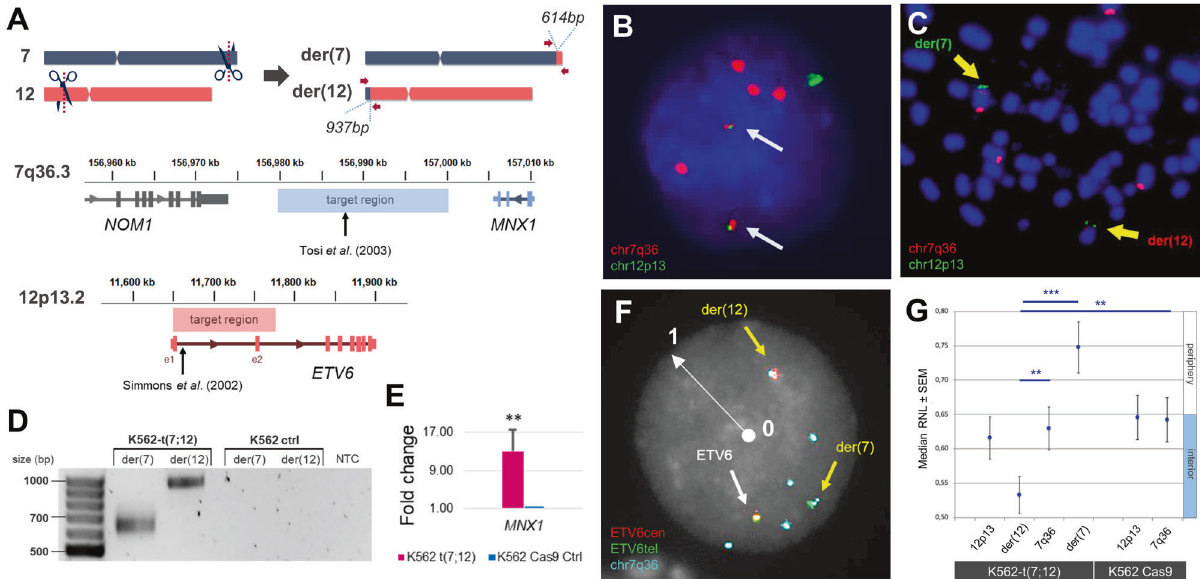
Fig. 1 Generation of t(7;12)(q36;p13) in K562 cells. A Schematic representation of target regions for CRISPR/Cas9-directed cleavage on chromosomes 7 and 12 used for guide RNA (gRNA) design. Fusion junctions are fl anked by arrows representing PCR primers used for con fi rmation, yielding products of 614 and 937 bp. Below, detailed location of the targeted regions on chromosome 7q36.3 and 12p13.2 with reference to known t(7;12) breakpoints used to generate the translocation. B FISH using the speci fi c t(7;12) probe XL t(7;12) MNX1/ETV6 (MetaSystems Gmbh, Altlussheim, Germany, Supplementary Table 3) hybridising chromosome 7q36 in red and chromosome 12p13 in green. Two yellow fusion signals, pointed by arrows, indicate the presence of t(7;12) in a representative interphase nucleus of K562-t(7;12). The karyotype of K562 is nearly tetraploid and harbours complex rearrangements, including a duplications of the 7q36 locus within the short arm of chromosome 7, hence showing fi ve 7q36 signals and two 12p13 signals [31] (Supplementary Fig. 1). C Metaphase spread of K562-t(7;12) hybridised with the same probe shows the presence of derivative chromosomes der(7) and der(12), pointed by arrows. D Con fi rmation of the presence of t(7;12) in K562-t(7;12) but not K562 control ( ‘ ctrl ’ ) cells (K562 electroporated with Cas9 only) by PCR ampli fi cation of fusion junctions and product separation on agarose gel; bands correspond to the predicted sizes shown in A . NTC no template control. E qRT-PCR validation of overexpression of MNX1 in K562-t(7;12) compared to K562 control. The fold change was calculated using the ΔΔ Ct method by normalisation to the endogenous gene HPRT1 . Error bars represent standard deviation (SD) of n = 3. Primers are reported in Supplementary Table 4. F A custom-made 3-colour probe (MetaSystems dual-colour ETV6 + PAC-derived RP5-1121A15) hybridising ETV6 portions in red (centromeric) and green (telomeric), and the MNX1 locus in cyan (Supplementary Fig. 1 and Supplementary Table 3), allowed visualisation of both derivative chromosomes in interphase nuclei (pointed by yellow arrows). The white radius arrow represents the distance between nuclear interior (value = 0) and nuclear periphery (value = 1), which was used in the calculation of radial nuclear locations (RNL). G RNL of der(7) and der(12) signals in K562-t(7;12) interphase nuclei. The RNL values are expressed as median values of individual localisations of FISH signals (200 nuclei analysed per condition). Errors bars represent standard error of the mean (SEM). Values closer to 0 indicate an internal position within the nucleus (described in detail in Federico et al. mechanism of MNX1 overexpression in t(7;12) leukaemia, with RESULTS AND DISCUSSION relocalisation of the der(12) containing the translocated MNX1 By delivery of CRISPR/Cas9 ribonucleoprotein (RNP) complexes gene to a more internal transcriptionally active position within the targeting clinically accurate breakpoints described by Tosi et al. [5] nucleus, where expression of MNX1 can be triggered [7]. We used and Simmons et al. [4] (Fig. 1A and Supplementary Table 1), we nuclear localisation analysis to understand whether this phenom- were able to achieve the t(7;12) rearrangement in the leukaemia enon was recapitulated in the K562 model. FISH using a custom cell line K562, as con fi rmed by fl uorescence in situ hybridisation 3-colour probe allowed to distinguish both derivatives in (FISH) (Fig. 1B, C and Supplementary Fig. 1) and ampli fi cation of interphase nuclei (Fig. 1F and Supplementary Fig. 1D – F) in order genomic fusion junctions by polymerase chain reaction (PCR) to calculate radial nuclear location (RNL) values for each locus with (Fig. 1D and Supplementary Fig. 2). CRISPR/Cas9 editing via RNP respect to their positioning towards the interior or peripheral complex electroporation allowed prompt activity without persis- nuclear space (Fig. 1F, G). As described in patients, the tent vector presence, as well as a more physiological recapitula- introduction of t(7;12) in K562 cells resulted in the altered tion of DSB generation leading to the formation of chromosomal positioning of the der(12) towards the nuclear interior, consistent translocations [14 – 18]. Consistent with only a fraction of cells with the relative gain in MNX1 expression (Fig. 1E). Conversely, the undergoing illegitimate repair of the breaks to form the der(7) containing the 5 ’ of ETV6 was repositioned towards the rearrangement, the frequency of t(7;12) formation was estimated periphery (Fig. 1G), also in agreement with the patient analysis by at 1% by FISH (Supplementary Fig. 1G). Homogeneous t(7;12)- Ballabio et al. [7]. Nuclear organisation as a mechanism of harbouring lines (K562-t(7;12)), as well as controls (K562-Ctrl), were regulation of MNX1 expression was also identi fi ed in leukaemias obtained by single cell cloning by limiting dilution and screened harbouring different interstitial deletions of chromosome 7q [20]. by PCR, from which three clones were derived by subcloning Speci fi cally, the localisation of MNX1 was shown to be dependent (Supplementary Fig. 3). While MNX1 is already expressed in K562 cells [19], the on the GC-content of the chromosomal band harbouring the translocation further upregulated its expression (Fig. 1E), consis- proximal breakpoint, with MNX1 being expressed when break- tent with ectopic MNX1 overexpression in patients [7, 9, 11]. points affected GC-rich bands, which resulted in relocation of MNX1 towards the nuclear interior; in contrast, GC-poor Altered nuclear positioning has been proposed as a signi fi cant